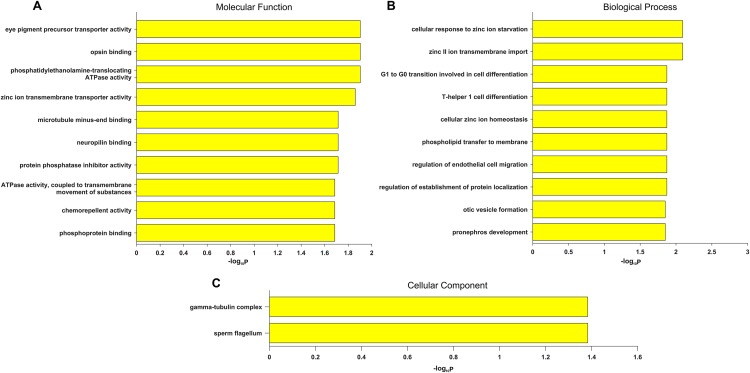
Top 10 significantly enriched GO terms only in candidate genes and not in the 709 eye disease genes.(A) Molecular function. (B) Biological process. (C) Cellular component. x-axis is the −log10 (BH adjusted P-value) from hypergeometric test of enrichment analysis. Complete list of enriched GO terms in Table S3.